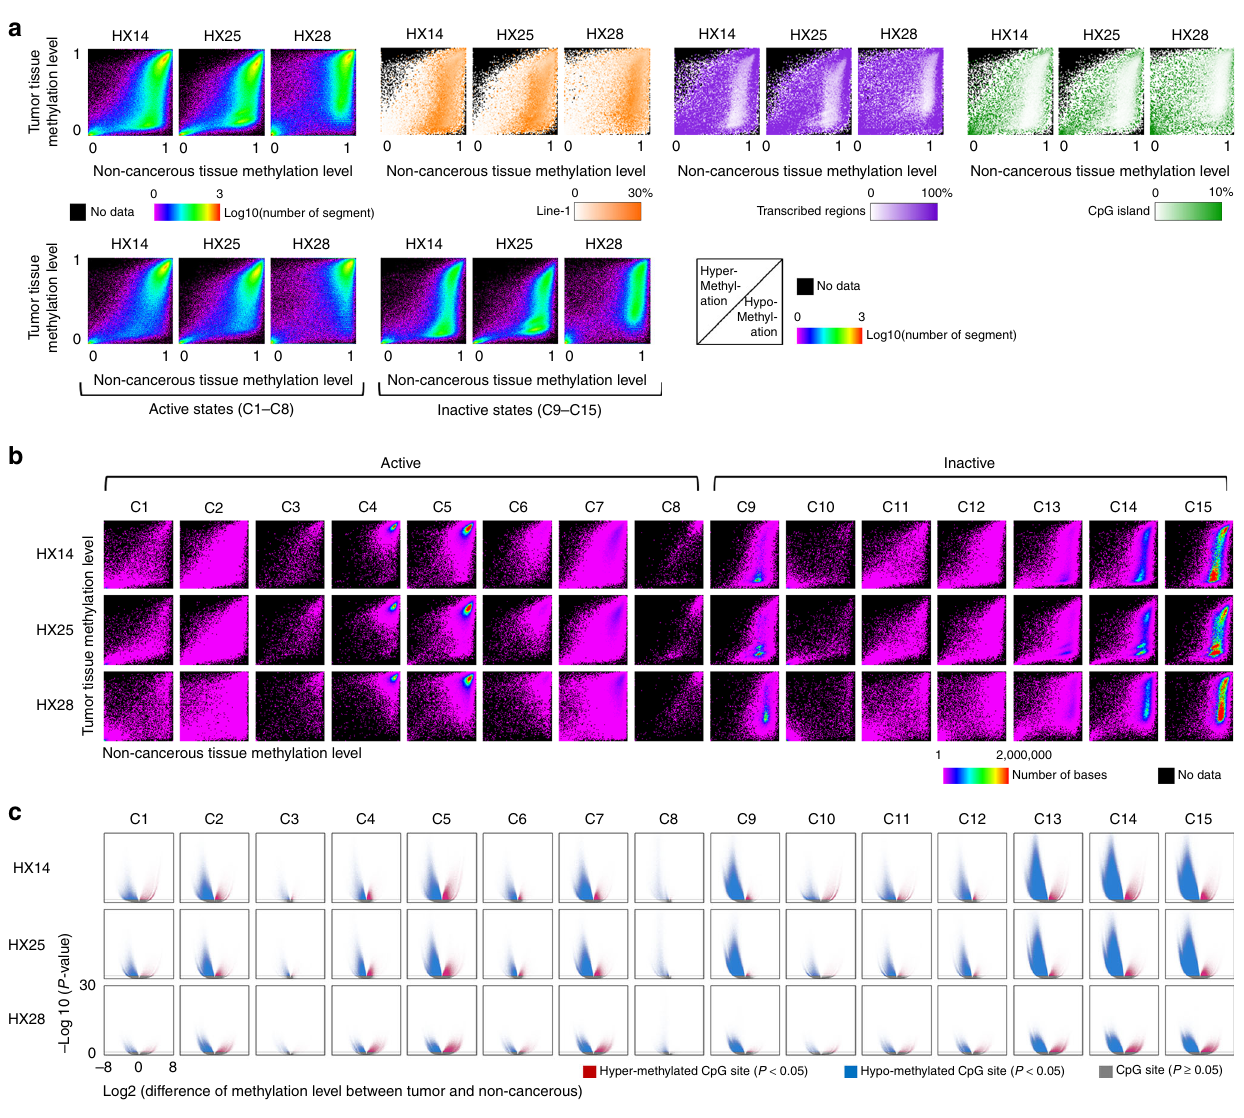
Fig. 1 Hypo- and hyper-methylation of three paired hepatocellular carcinoma genomes. a In the upper panel, the left three plots show the methylation levels of the regions of tumor genomes ( y -axis) or non-cancerous genomes ( x -axis) delimited according to the 15 epigenomic segments. The color indicates the number of region. The orange plots show the density of LINE-1, purple plots show the density of transcribed regions, and green plots show the density of CpG islands. These densities were calculated for each fraction of the left three images, which were divided into 100 × 100 areas. In the lower panels, the genomic regions of the upper left three plots are shown separately for active and inactive chromatin state. b Methylation levels of tumor and non- cancerous genomes in the 15 epigenomic segments. The color indicates the number of bases. c Volcano plot of the differences in the methylation levels of CpG sites between tumor and non-cancerous genomes. Each dot represents a CpG site. Red indicates that the methylation level in the tumor genome is signi fi cantly ( P < 0.05 using Fisher ’ s exact test) higher than in the non-cancerous genome, blue indicates lower, and gray indicates P ≥ 0.05. The x -axis indicates the log2 fold-change of the methylation level; the y-axis indicates the minus log10 of the P